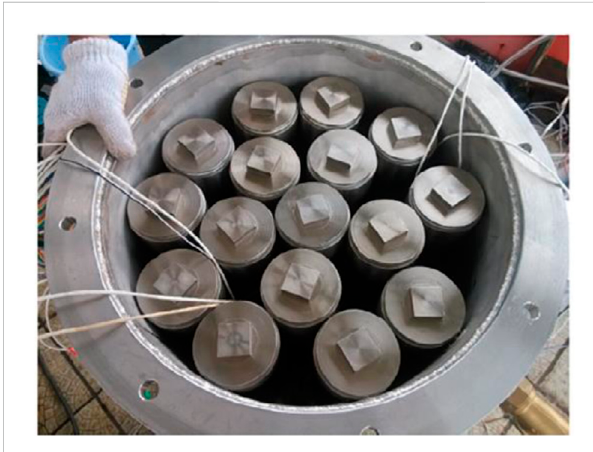
FIGURE 5 Photographic view of lab facilities of the TES tank (Zhang et al., 2016). License Number: 5526340217542.